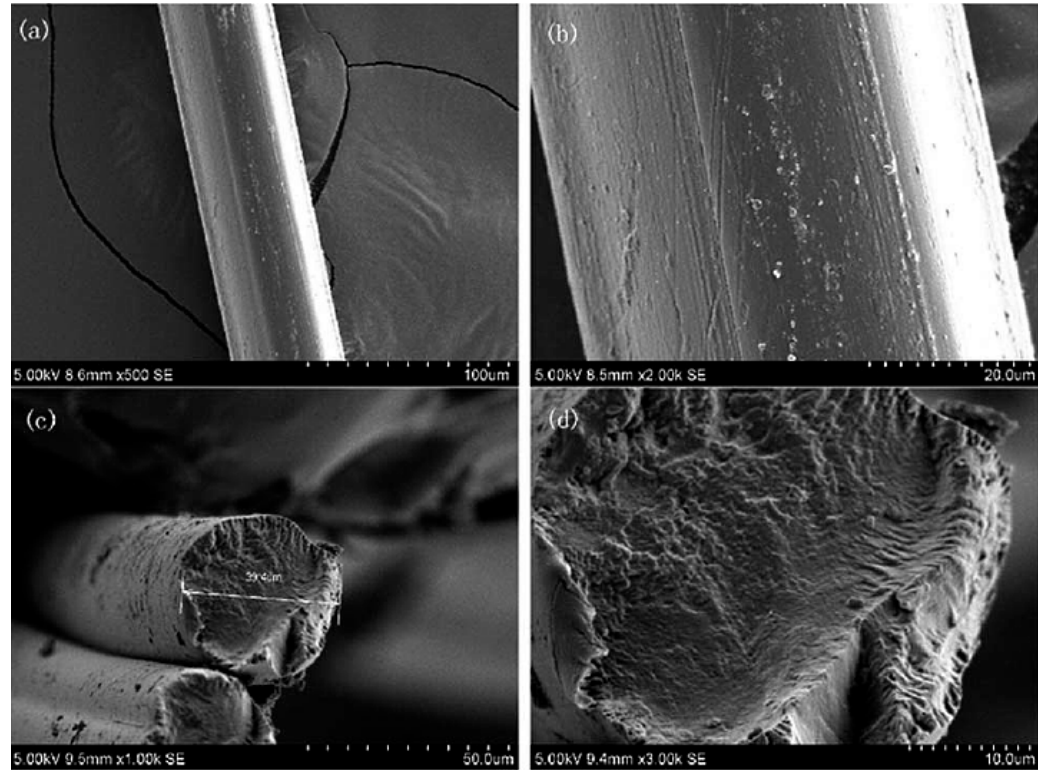
Figure 9. Scanning electron microscope images of cellulose fibers from TBAAcO/DMSO/18-crown-6: ( a ) side surface section, ( b ) magnified side surface section, ( c ) cross-section with diameter, ( d ) magnified cross-section; reproduced from [120] with permission of The Royal Society of Chemistry.